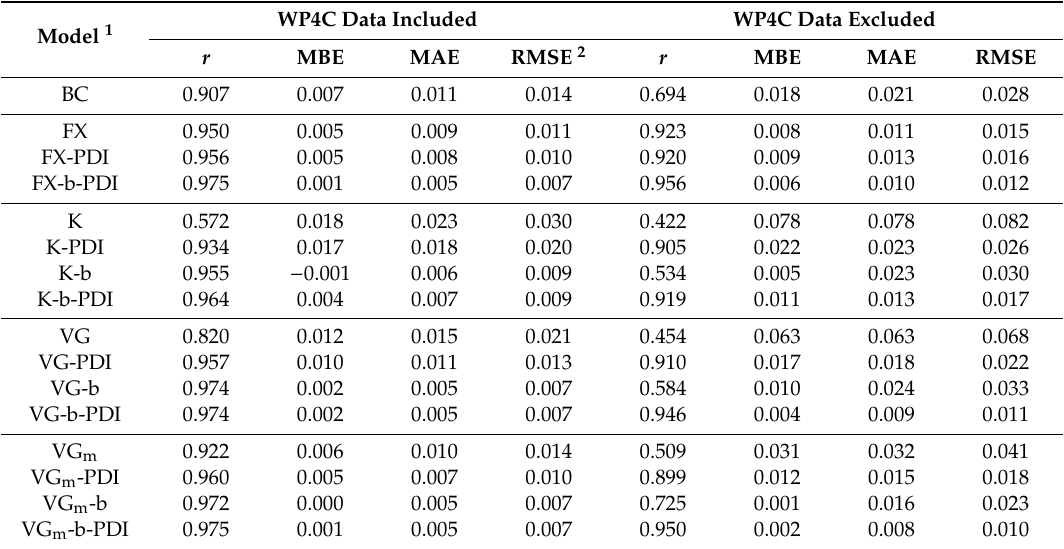
Table 5. Performance of the 16 models at the Soil Water Retention Curve (SWRC) dry-end (pF